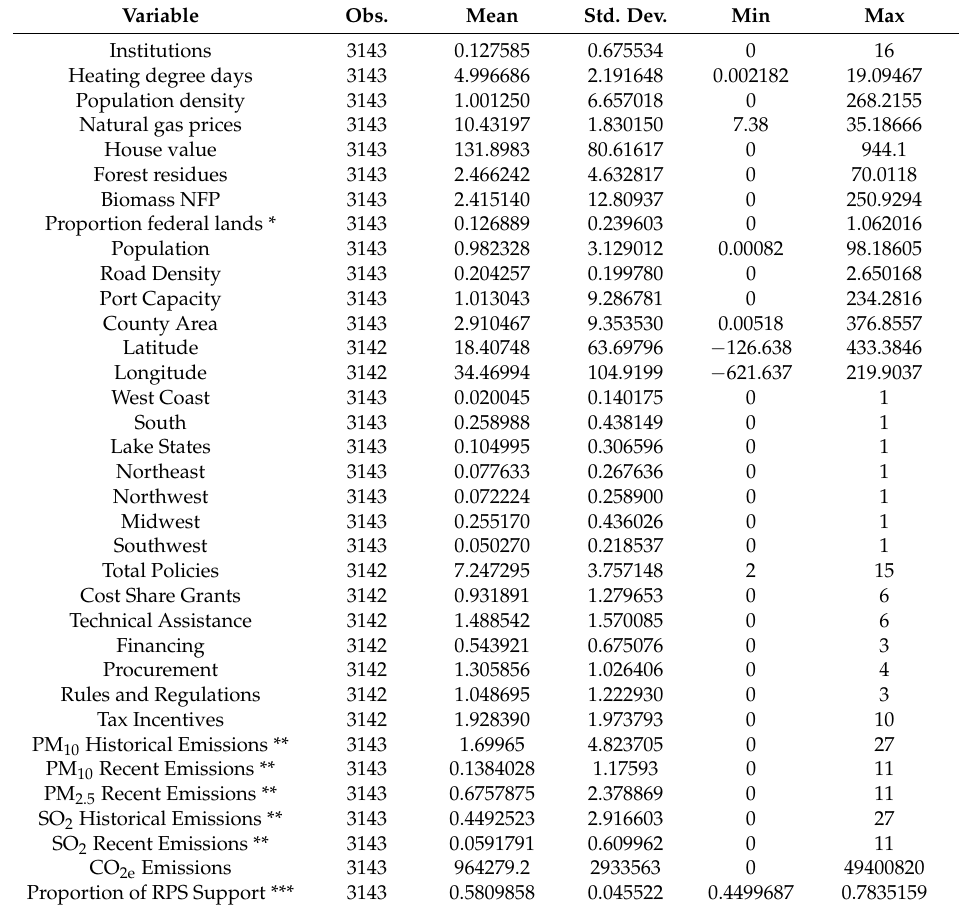
Table 3. Descriptive statistics for the variables used in the ZINB model, including the number of observations (obs.), mean, standard deviation (std. dev.), minimum value (min) and maximum value